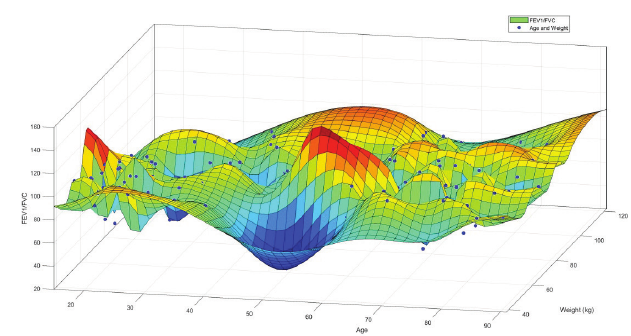
Figure 3. Surface plots of FEV1/FVCversus age and weight variables